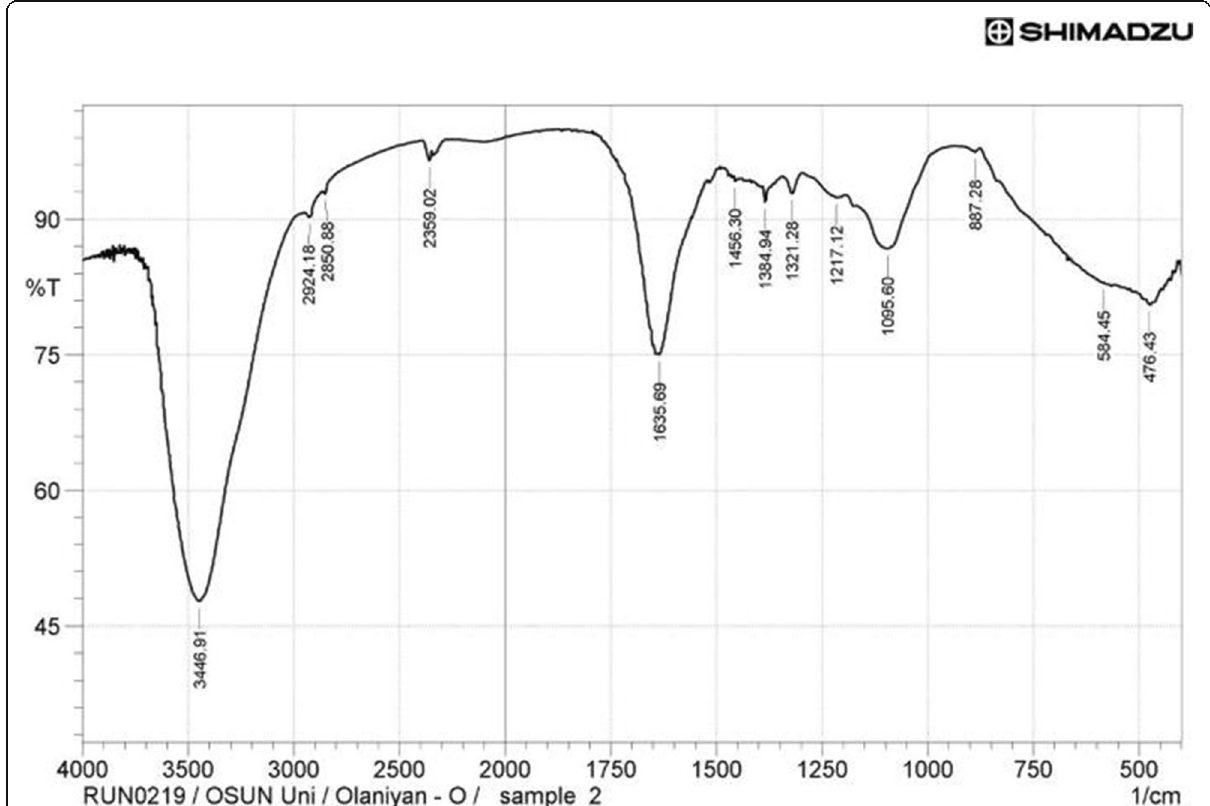
Fig. 2 Characterization of crude hot water extract of Cassava biogas slurry (CPH) to elucidate the chemical groups present in the bioactive compounds using